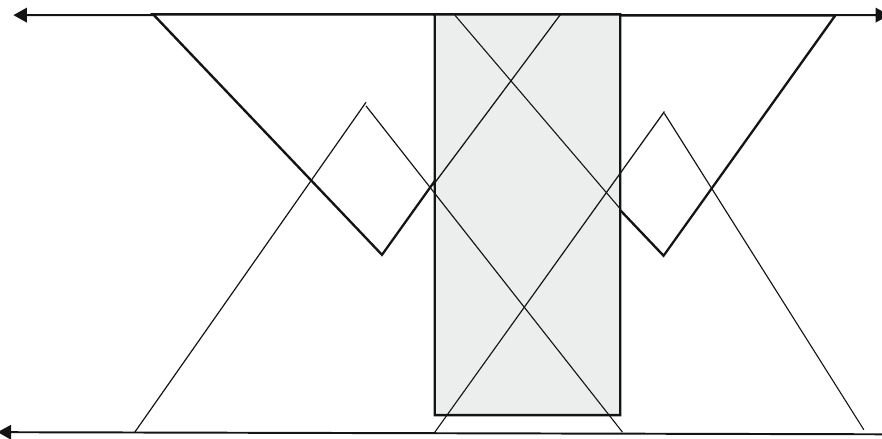
Fig. 1 Similarity of two N-Pythagorean fuzzy sets